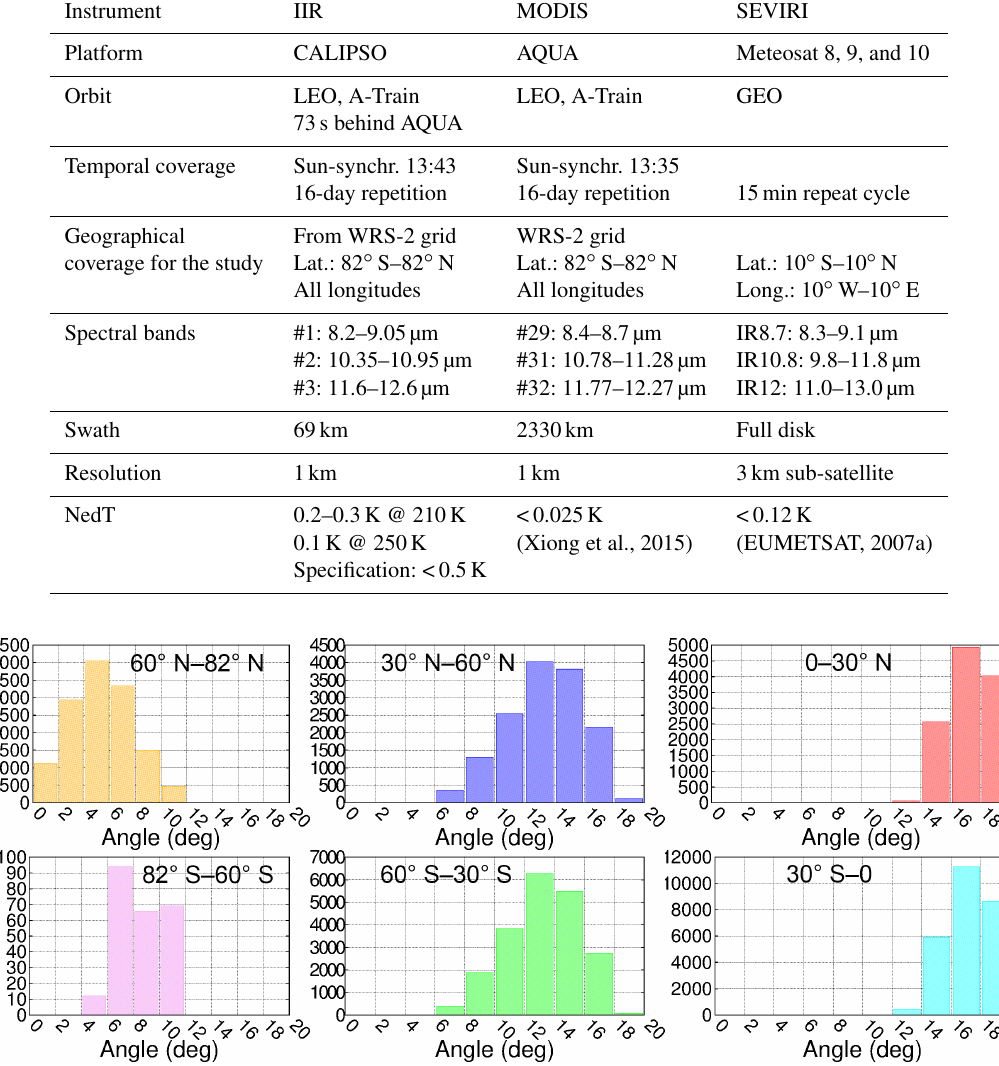
gitude for the prime satellites. SEVIRI data are from three different prime geostationary satellites since June 2006: Me- teosat 8 until 11 April 2007, then Meteosat 9 until 21 Jan- uary 2013, and currently Meteosat 10. IIR and SEVIRI are best compared when SEVIRI viewing angles are smaller than 10 ◦ to be close to IIR quasi-nadir observations, therefore, at latitudes between 10 ◦ N and 10 ◦ S and longitudes between 10 ◦ W and 10 ◦